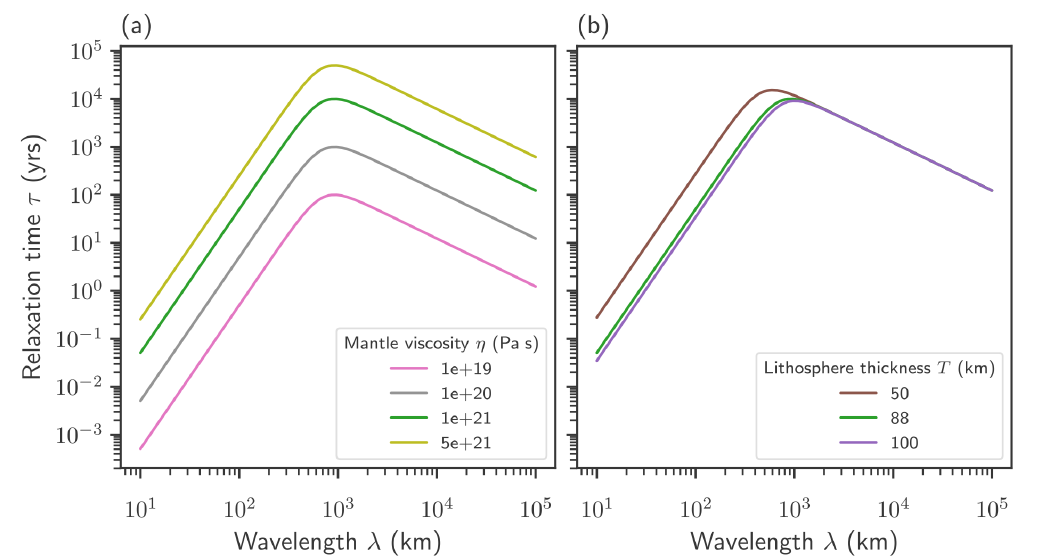
Figure A1. Spectrum of the relaxation time vs. wavelength of the load change for different mantle viscosities and lithosphere thicknesses, as shown in Bueler et al. (2007), Eq.